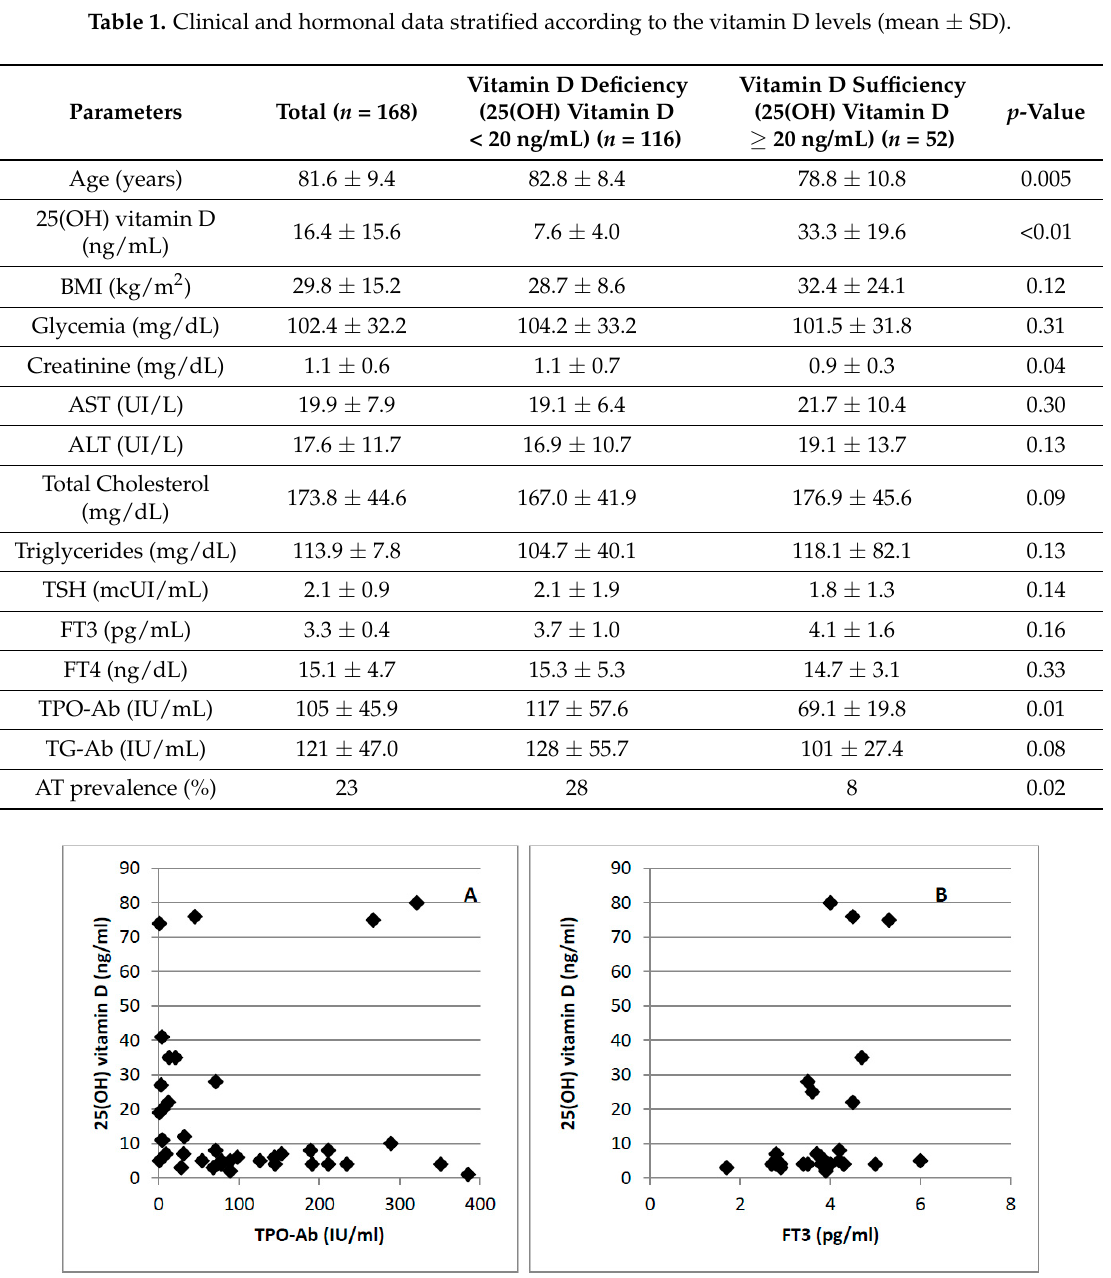
Figure 1. Correlations between 25(OH)D concentration and TPO-Ab ( r = − 0.27, p = 0.03) ( A ) and FT3 ( r = 0.35, p = 0.006) ( B ).